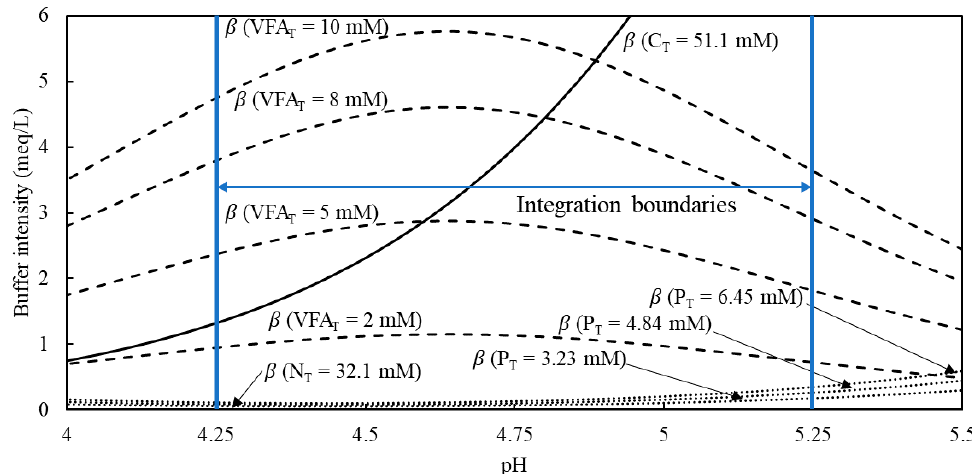
Figure 1. Buffer intensity curves for the various weak acid systems typically present in anaerobic digestion solutions at the pH range relevant for the titration procedure suggested in this work. Three total volatile fatty acids (VFA T ) and P T values and one C T (51.1 mM) and N T (32.1 mM) values were considered (EC = 6 mS/cm, Temp = 25 °C).